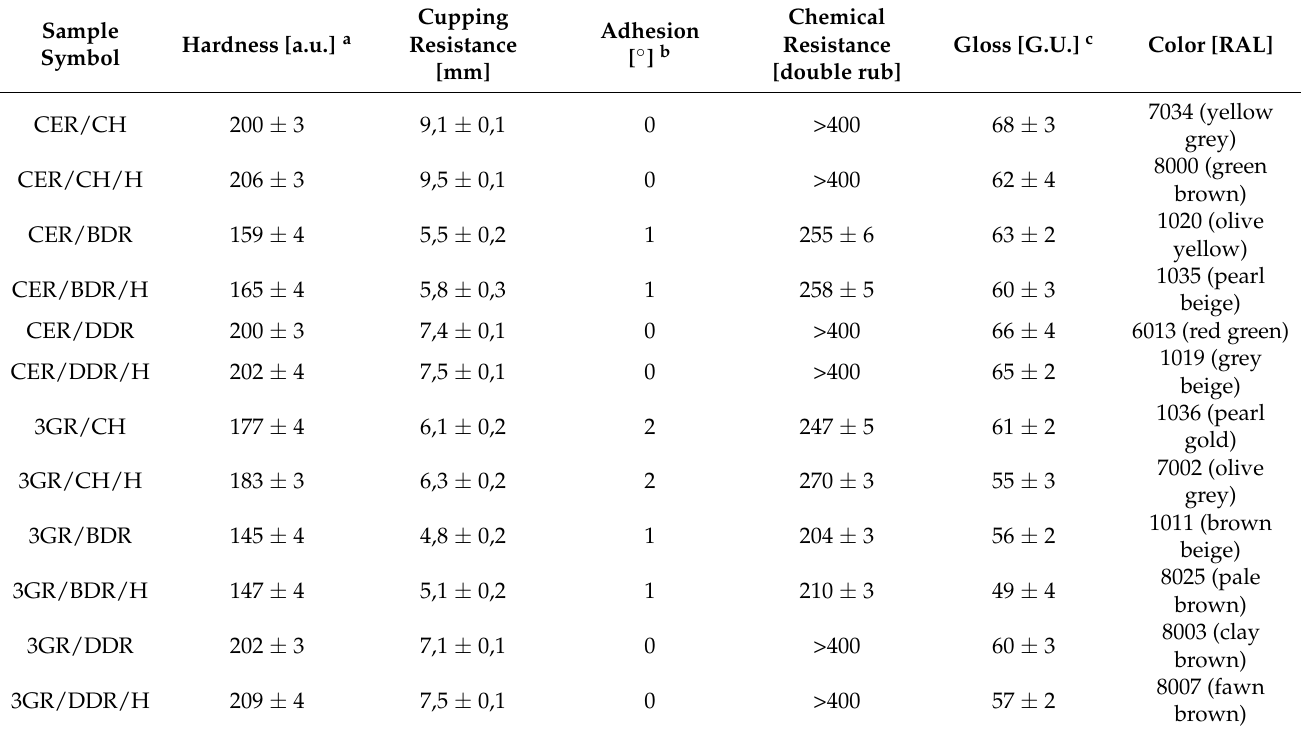
Table 2. Mechanical and functional properties of the prepared